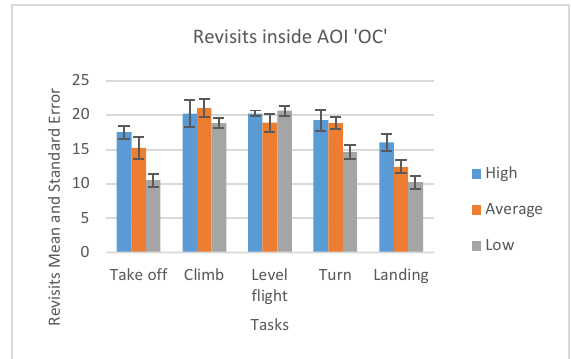
Figure 18. Number of revisits AOI ‘OC’ for five flight phases for psychological selection stream with associ- ated Standard errors.